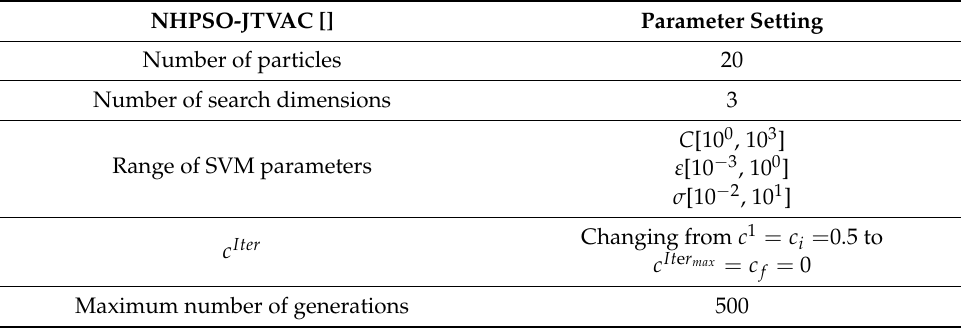
Table 3. Parameter setting of the NHPSO-JTVAC algorithm.